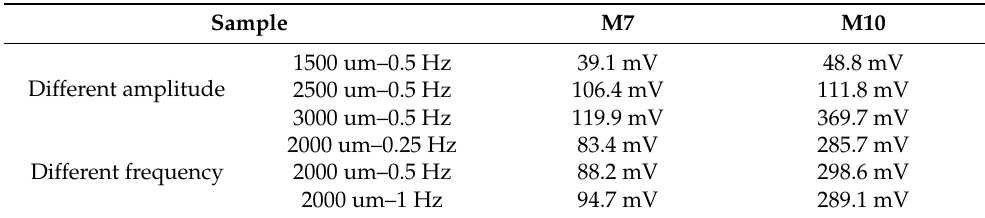
Figure 8. The open-circuit voltage of the transducers is made of PVDF membranes ( A ) M7 and ( B ) M10 as a function of time under different amplitudes and frequencies. Table 4. Piezoelectric voltage outputs of transducers made of M7 and M10 under different amplitudes and